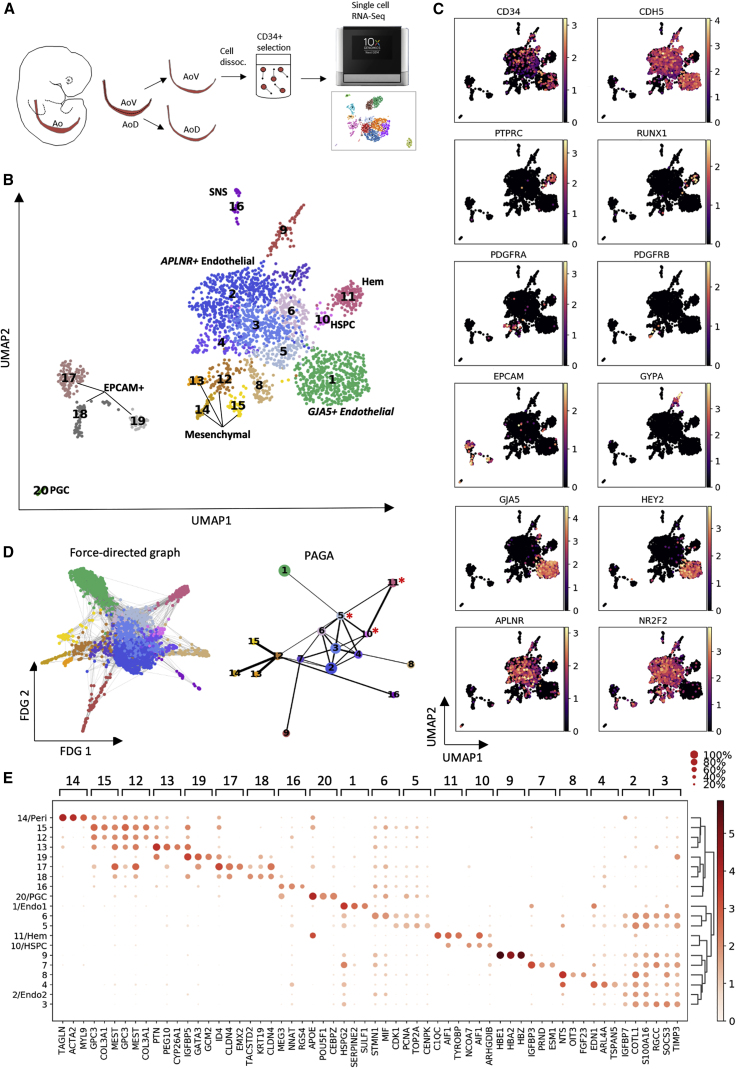
Exploring Heterogeneity of the Hematoendothelial Population Using Single-Cell RNA-Seq Analysis(A) Experimental strategy for single-cell analysis. A CS16 Ao was bisected into V (AoV) and D (AoD) domains. CD34+ cells were bead purified from the AoV cell suspension and subjected to 10X single-cell sequencing.(B) UMAP with Leiden clustering of the CS16 AoV single-cell dataset (N = 1, n = 2,379 single cells). Hem, hematopoietic; HSPC, Hem stem/progenitor cell; SNS, sympathoadrenal nervous system). The central endothelial network (CL1–CL7) links with large arterial (GJA5+) CL1 and HSPC cluster 10 (CL10), which transits into mature blood cells (CL11). Note that the arterial CL1 linked to HSPC CL10 via the bridge CL5 with a downregulated arterial signature (evident from force-directed graph visualization; D). For a detailed description of all CLs, see Results.(C) Mapped ln-normalized expression of key genes identifying cell subtypes.(D) Force-directed graph visualization and partition-based graph abstraction (PAGA) topology tree of cells from (B), excluding CL17–CL20. Note that HSPC CL10 is most strongly linked to the bridging CL5 with a downregulated arterial signature and downstream mature blood cells (CL.11), highlighted by asterisks. The width of edges in PAGA indicate the strength of connectivity between CLs.(E) Mean expression for top 3 markers in each CL revealed in (B) (the plot is ln normalized).